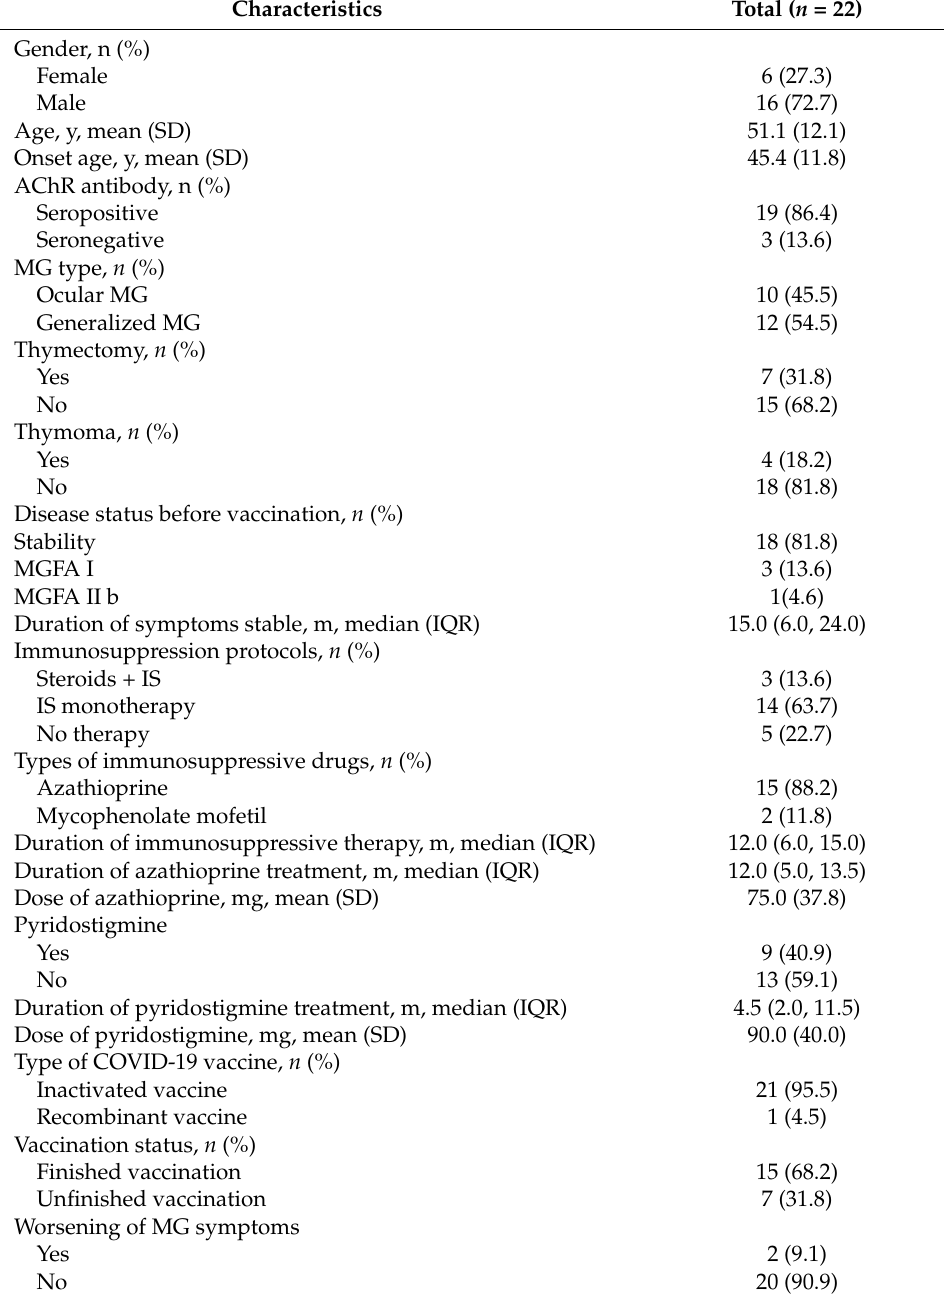
Table 1. Baseline Characteristics of Patients with Myasthenia Gravis Receiving the COVID-19 Vaccine.